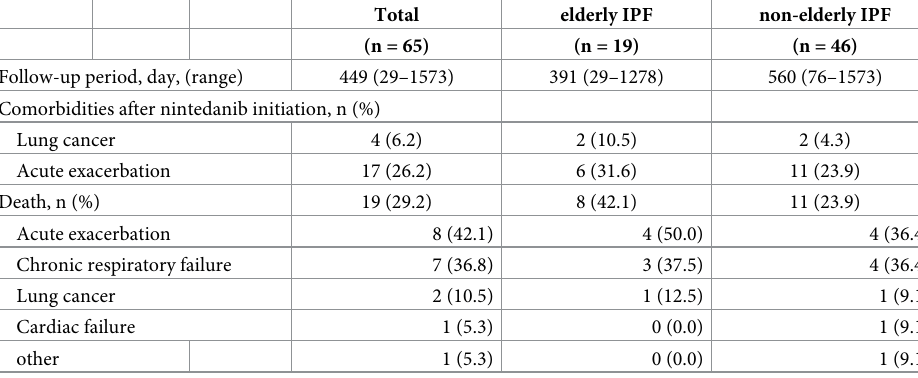
Table 5. Comorbidities and prognoses of IPF patients after nintedanib